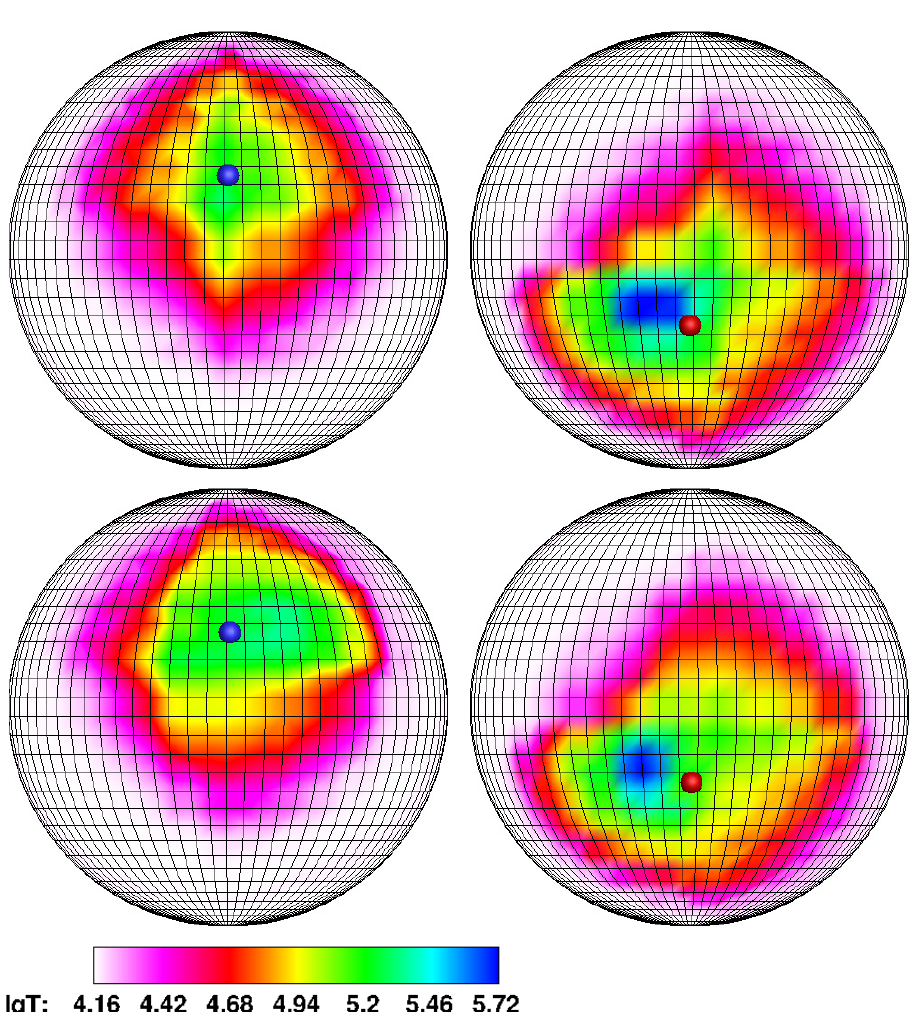
Figure 14. Temperature distribution over the accretor surface for the asynchronous polar with a non- offset dipole when switching the flow from the south magnetic pole to the north one. The temperature maps for Phase 1 ( upper panel) and for Phase 2 ( lower panel) are